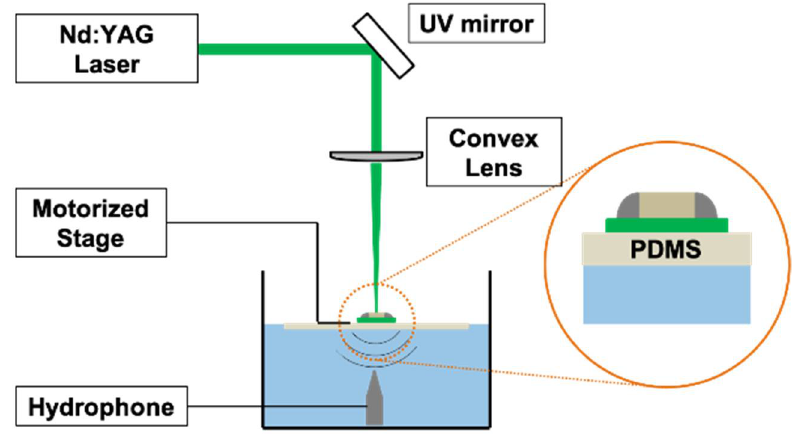
Figure 3. Schematic of noncontact laser ultrasonic system.